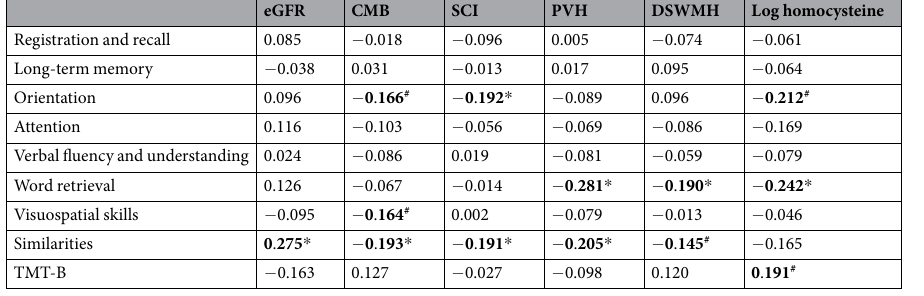
Table 3. Adjusted associations of cognitive domains with eGFR, small vessel diseases, and homocysteine. The table gives standardized regression coefficients (ß values) of eGFR, four types of SVD (SCI, CMB, PVH, or DSWMH), and log-transformed homocysteine levels for cognitive domains by multiple regression analysis adjusted for 12 covariates including age, sex, apoE4, prior cardiovascular disease, duration of diabetes mellitus, HbA1c, hypertension, dyslipidemia, log-transformed urine albumin to creatinine ratio, education, log- transformed serum vitamin B12, and log-transformed serum folate level. In this analysis, we coded SVDs as 0 (if absent) or 1 (if present). # P = 0.06–0.09, * P < 0.05, ** P < 0.01. Abbreviations are: eGFR, estimated glomerular filtration rate; 3 MS, Modified Mini-Mental State examination; TMT-B, Trail Making Test B; CMB, cerebral microbleed; SCI, silent cerebral infarction; PVH, periventricular hyperintensity; DSWMH, deep and subcortical white matter